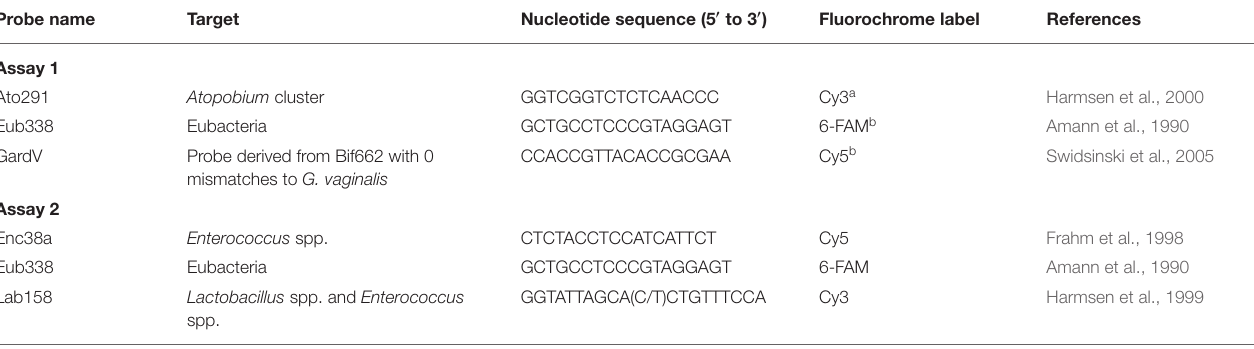
TABLE 2 | Oligonucleotide sequences of probes that were used in the FISH